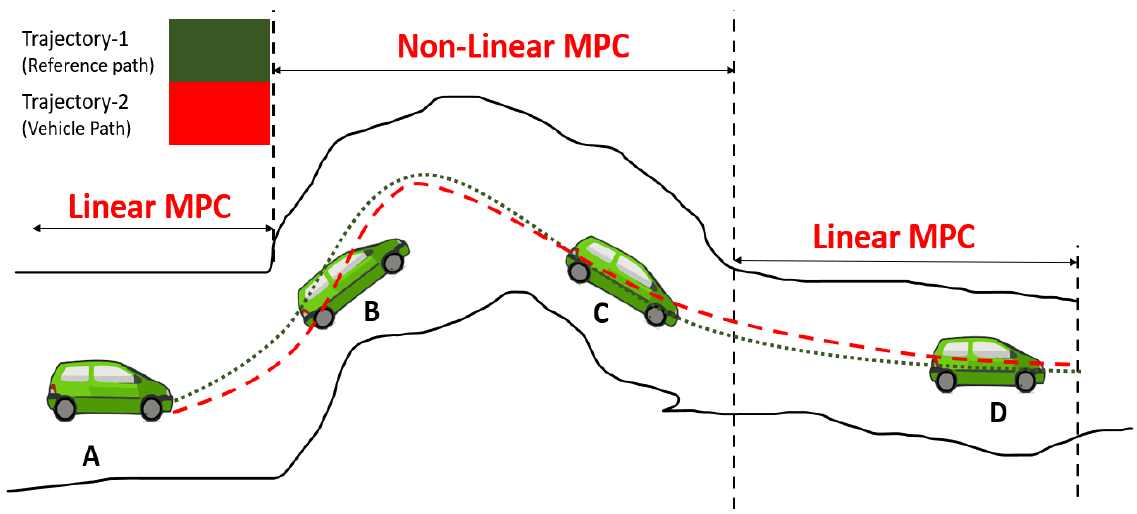
Figure 5. Combined linear and non-linear MPCs. Both techniques are applied in the proposed method.